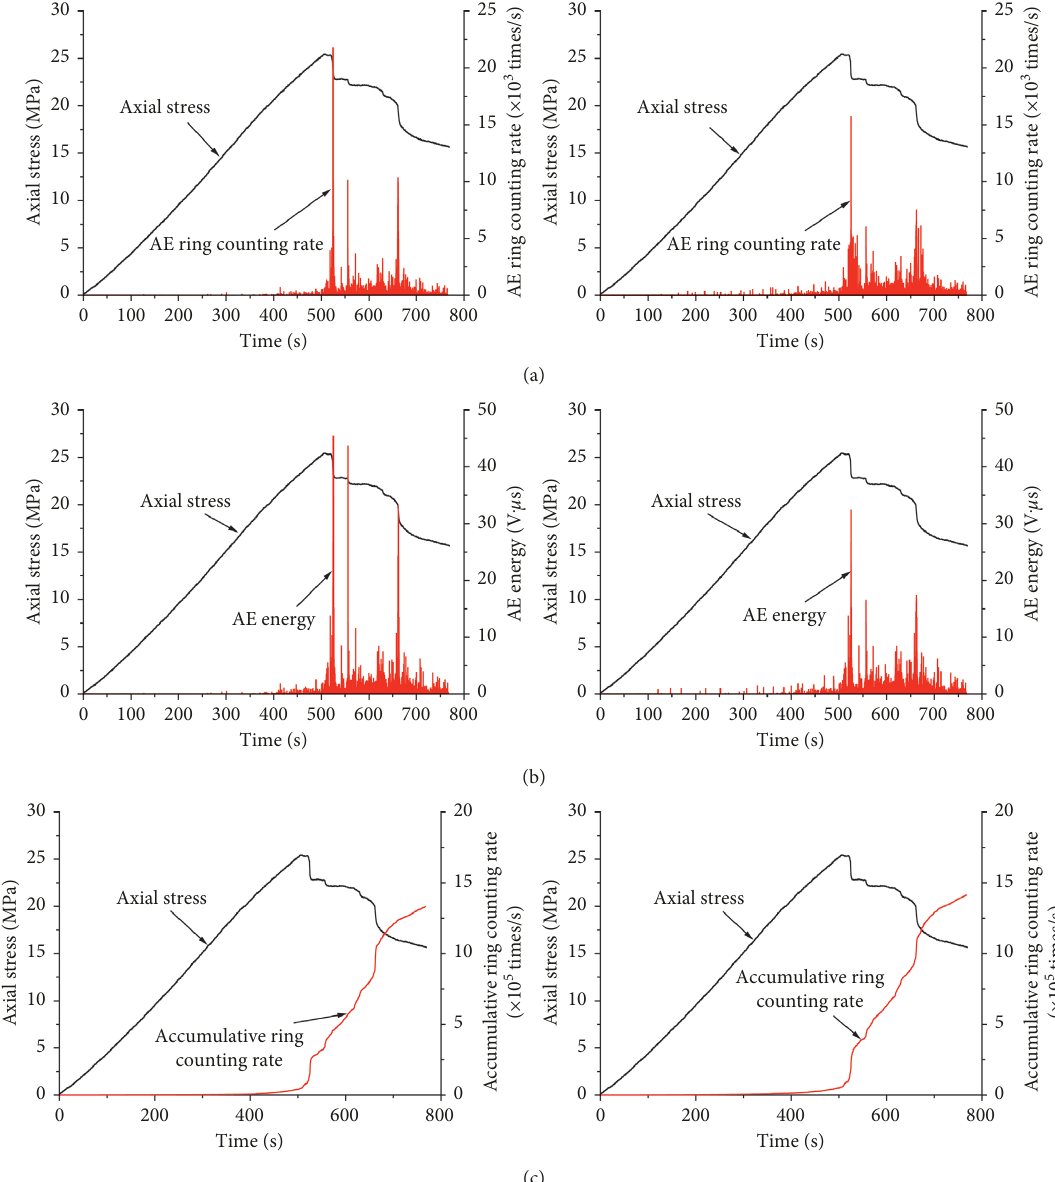
Figure 17: AE parameter curves of coal sample with AE detector outside and inside the triaxial chamber, respectively: (a) AE ringing count; (b) AE energy; (c) accumulative ringing